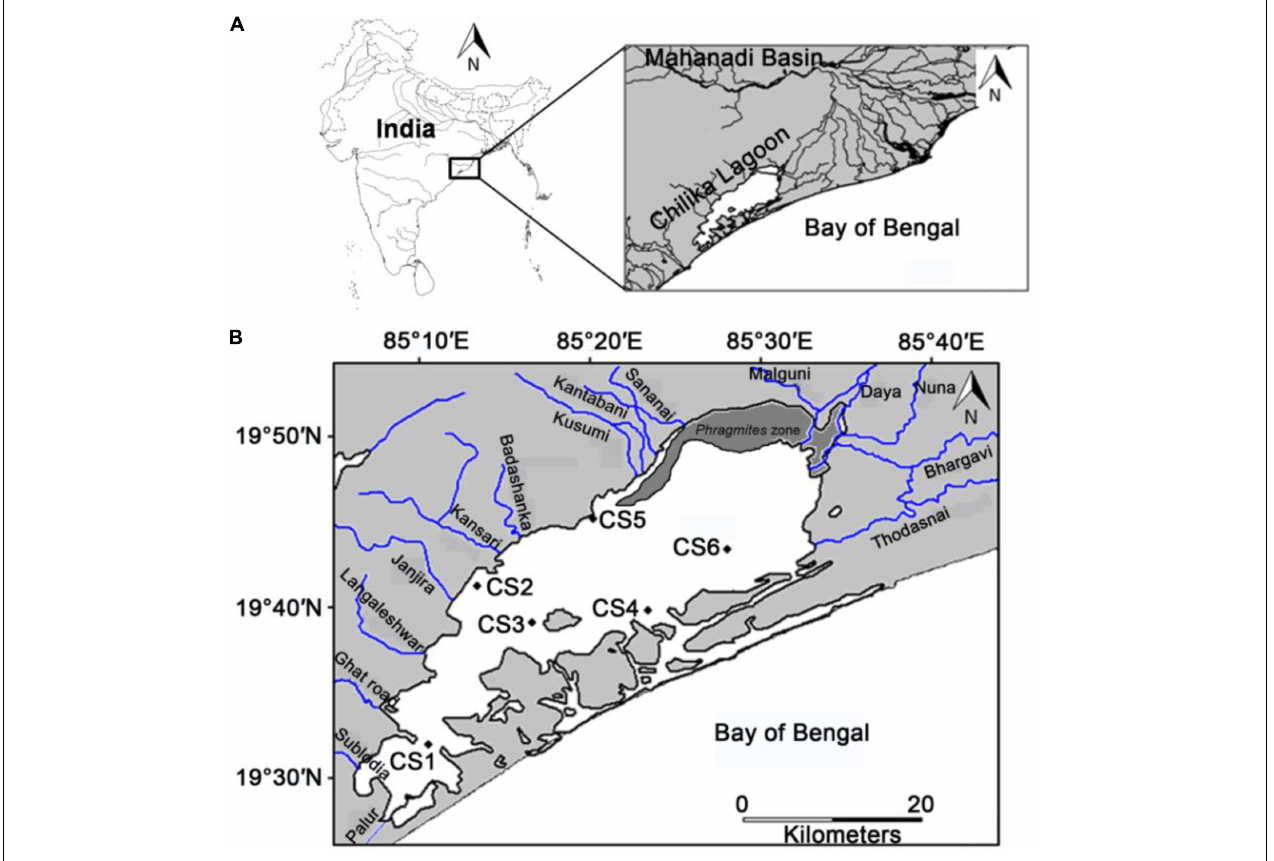
FIGURE 1 | (A) Location of the study area with respect to the Mahanadi basin, the major source of freshwater influx in the Chilika lagoon (B) location of the sampling stations with respect to the different rivers that flow into the lagoon and can act as potential point sources for